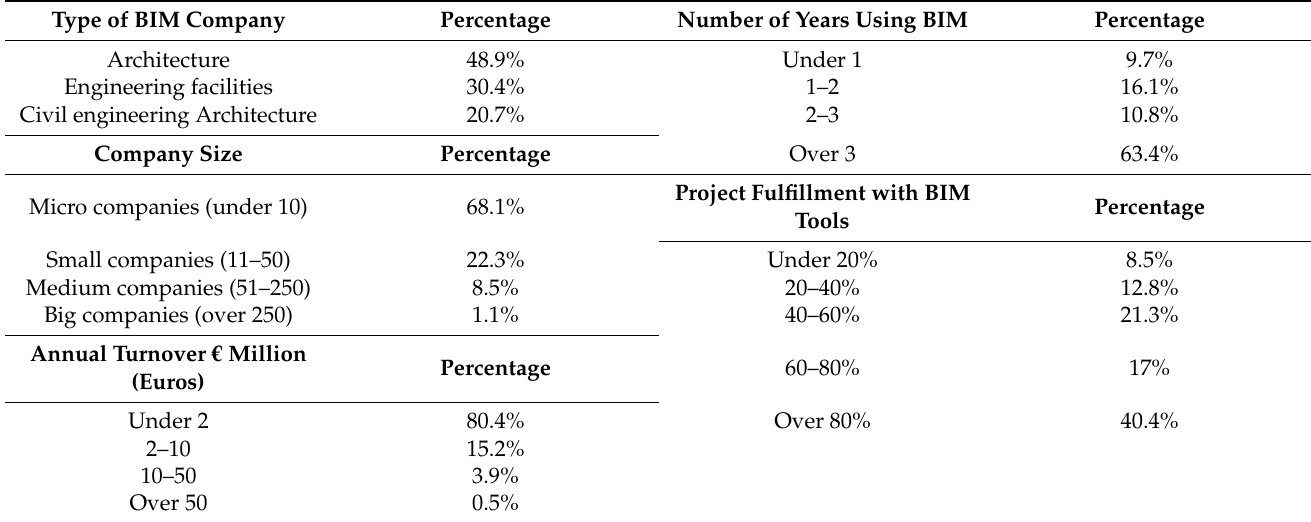
Table 2. Descriptive statistics of the sample.